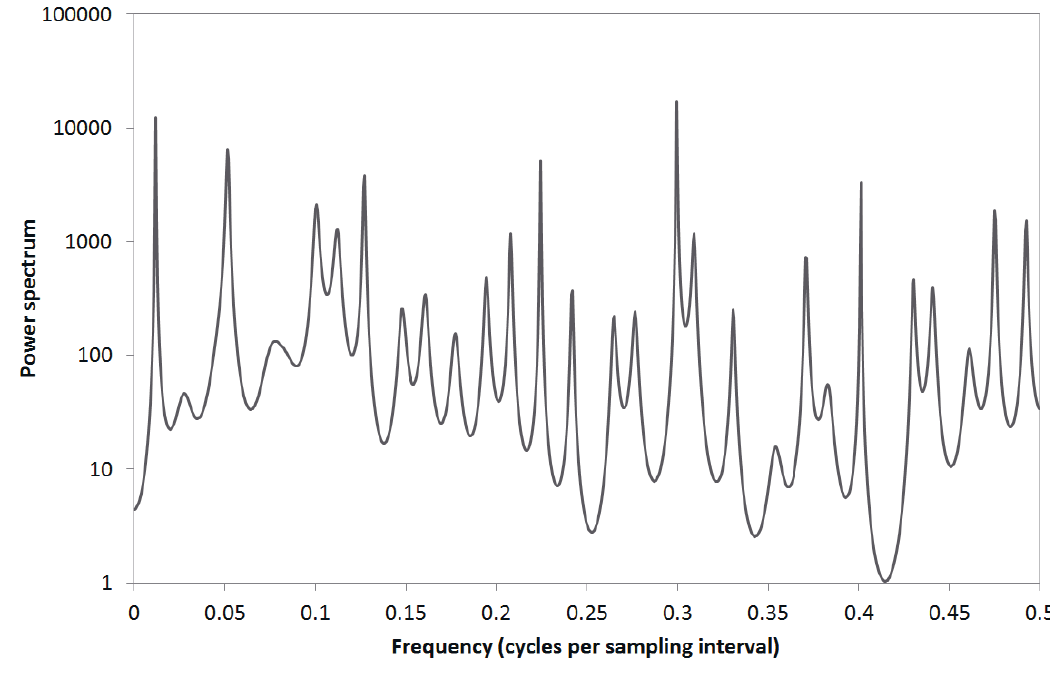
Figure 2. Power spectrum of the time series shown in Figure 1, estimated by maximum entropy with an autoregressive model of 64 terms. The Nyquist frequency is 0.5 which corresponds to a period of 2 arbitrary units of time.